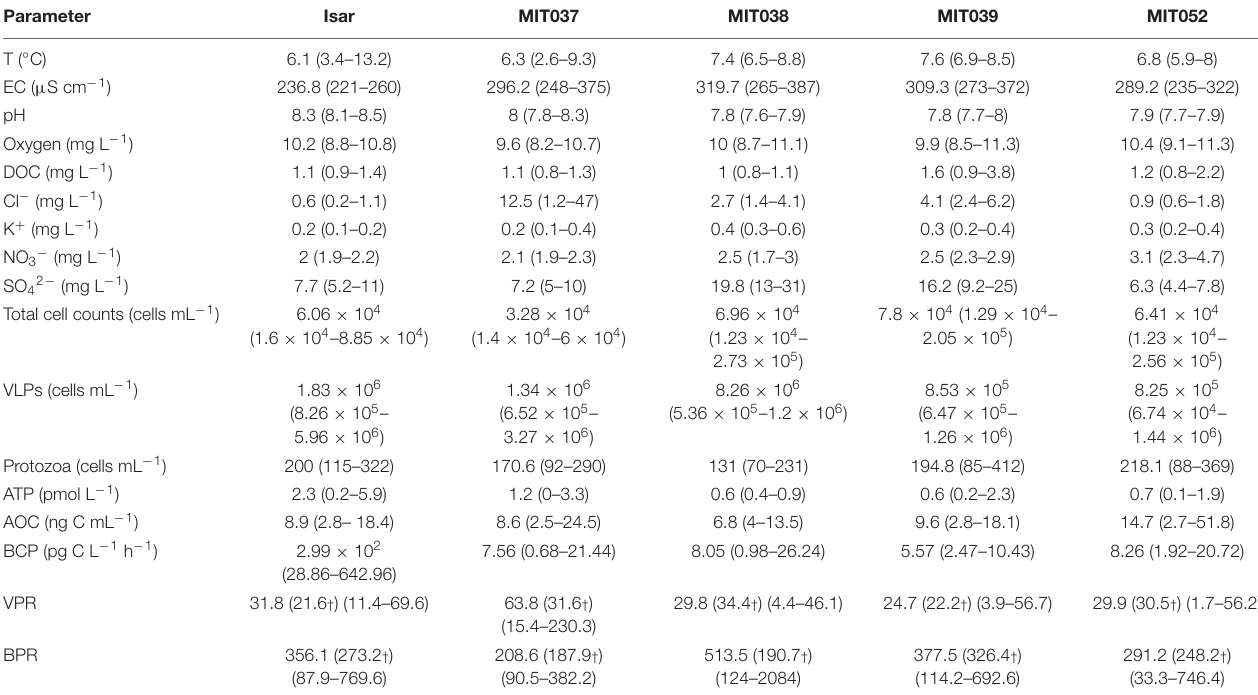
TABLE 1 | Mean values of physicochemical and microbiological parameters of a 1 year sampling